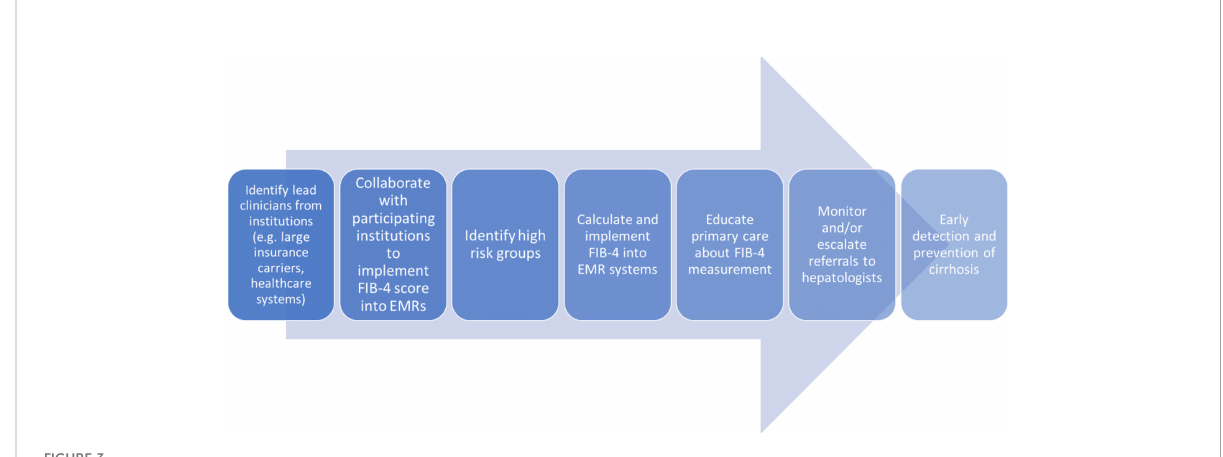
FIGURE 3 Process of FIB-4 Implementation at various healthcare systems.